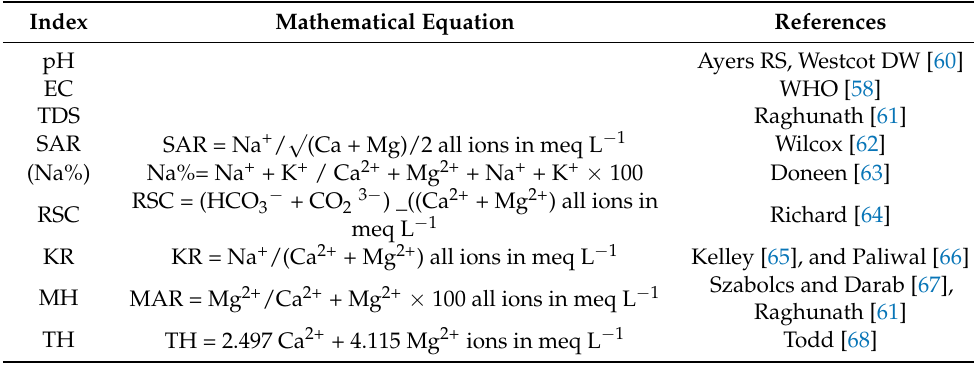
Table 1. Groundwater quality indices for